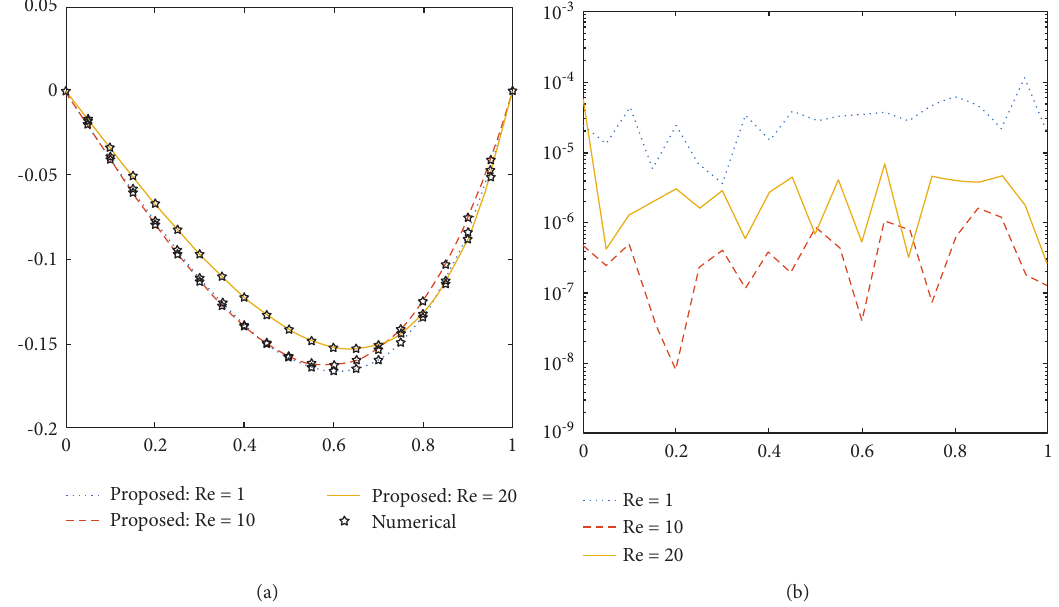
Figure 7: Evaluation of proposed LMA-BANN with the numerical reference results for the MPFPCMI scenario 2: (a) outcomes for different value of Re in g ; (b) error plot of Re in velocity g .